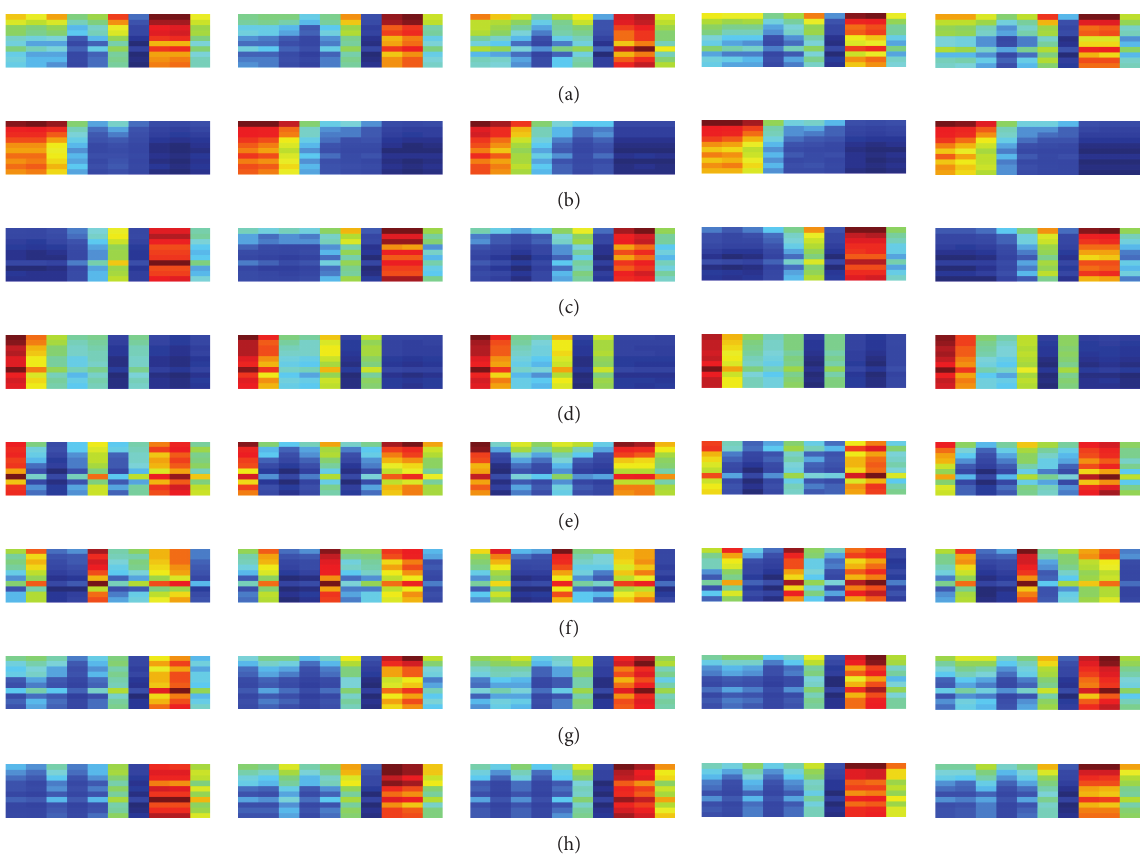
Figure 8: The feature matrices of eight engine states obtained by 2DNMF (every row represents one engine state and five samples of each engine state are displayed): (a) normal state; (b) first cylinder misfire; (c) second cylinder misfire; (d) first and second cylinder misfire; (e) too